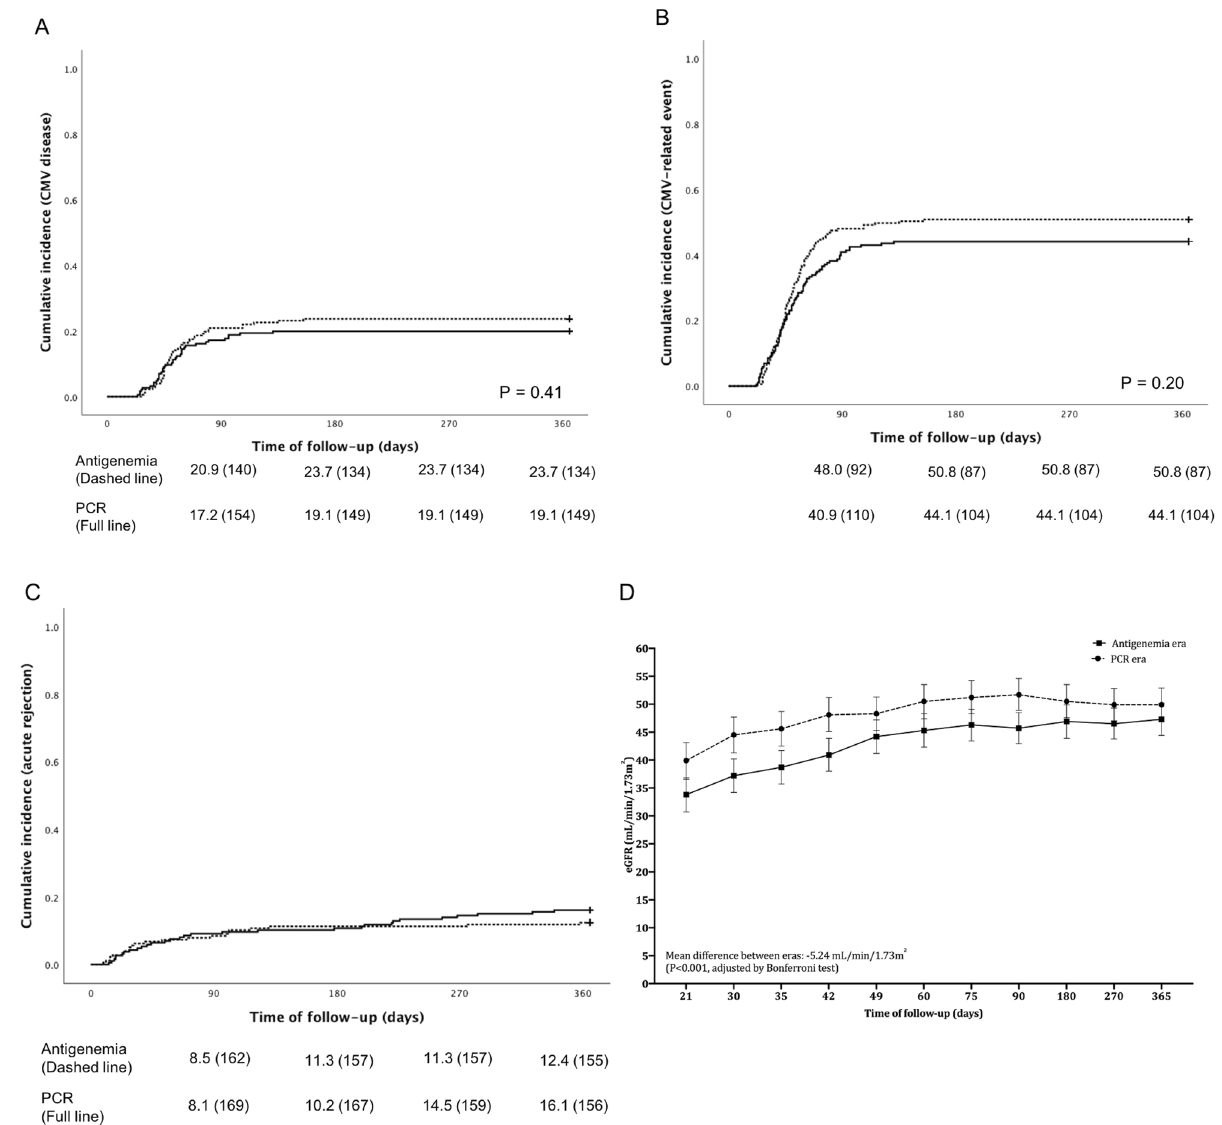
Figure 3. Primary and secondary outcomes: CMV-related events, CMV disease, acute rejection and graft function. ( A ) cumulative incidence of the first CMV-related event (infection or disease) according to the era. ( B ) cumulative incidence of CMV disease according to the era. ( C ) cumulative incidence of acute rejection according to the era. ( D ) graft function assessed by estimated glomerular filtration rate according to the era. In the figures ( A – C ), the P-value was calculated by log-rank. The means of graft function over time and according to era were compared by generalized estimating equation modeling and adjusted by Bonferroni test. Squares and circles in the plot represent mean and bars the 95% confidence interval. RT-PCR, real-time polymerase chain